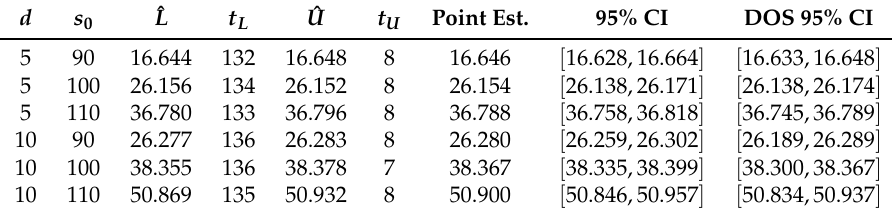
Table 1. Price estimates for max-call options on 5 and 10 symmetric assets for parameter values of r = 5%, δ = 10%, σ = 20%, ρ = 0, K = 100, T = 3, N = 9. t L is the number of seconds it took to train τ Θ and compute ˆ L . t U is the computation time for ˆ U in seconds. 95% CI is the 95% confidence interval (6). The last column lists the 95% confidence intervals computed in Becker et al. (2019a).